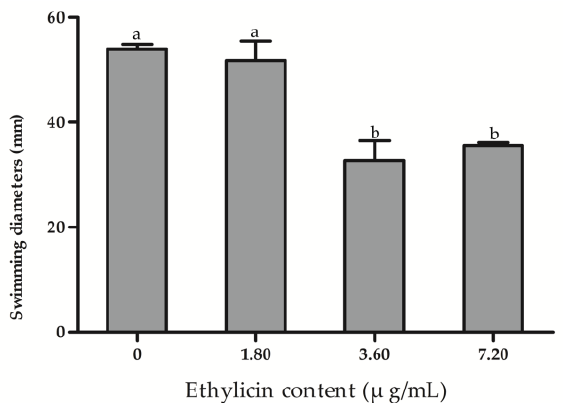
Figure 6. The measured value of the longest colony diameter. The data represent the means ± SD of three replicate samples. The different letters (a, b) indicate significant differences at p < 0.05.